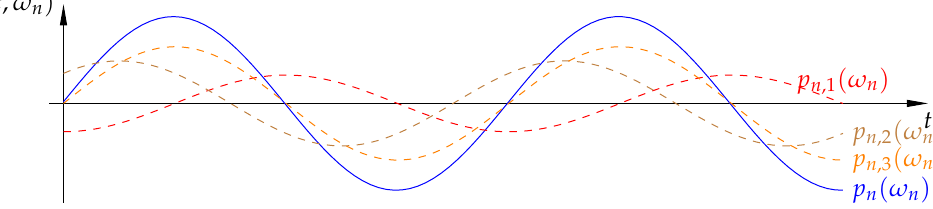
Figure 1. Multiple single echo signals from three targets p n ,1 ( ω n ) , p n ,2 ( ω n ) , p n ,3 ( ω n ) and the corresponding echo sum p n ( ω n )